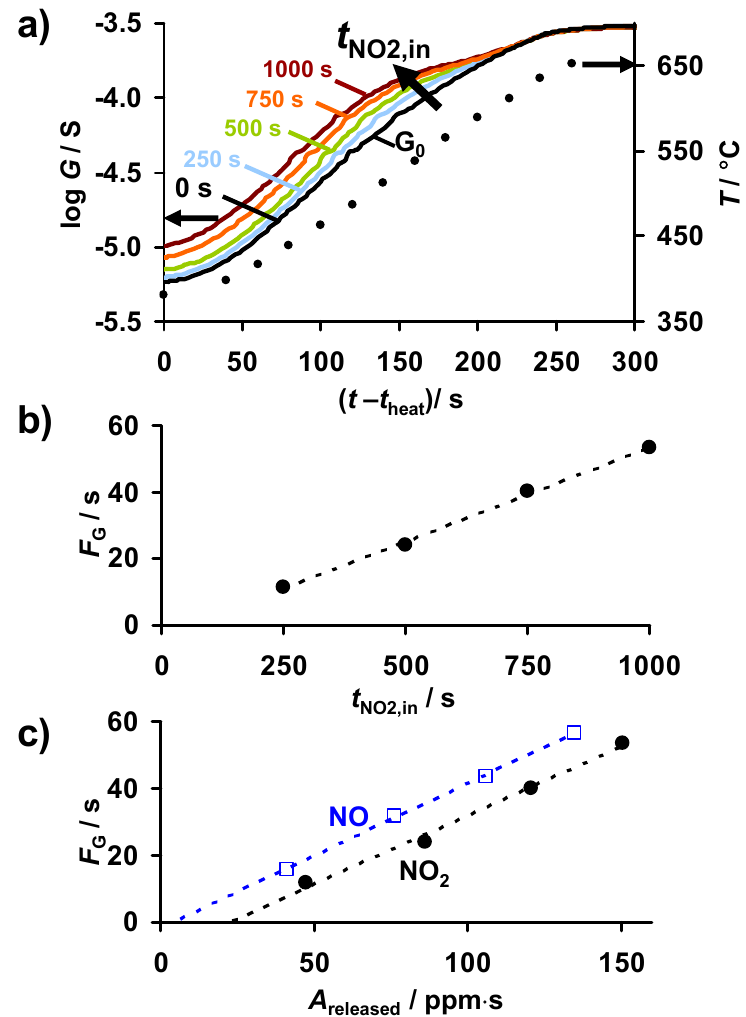
Figure 11. eTPD results after 8 ppm NO for up to 1,000 s: ( a ) conductance log G and x temperature T during TPD, ( b ) cumulated electrical response F (calculated acc. to G Equation (4)) vs. the NO loading time t , ( c ) F as a function of the amount of x NO2,in G released NO A for NO and NO loading, as determined in Figure x released 2